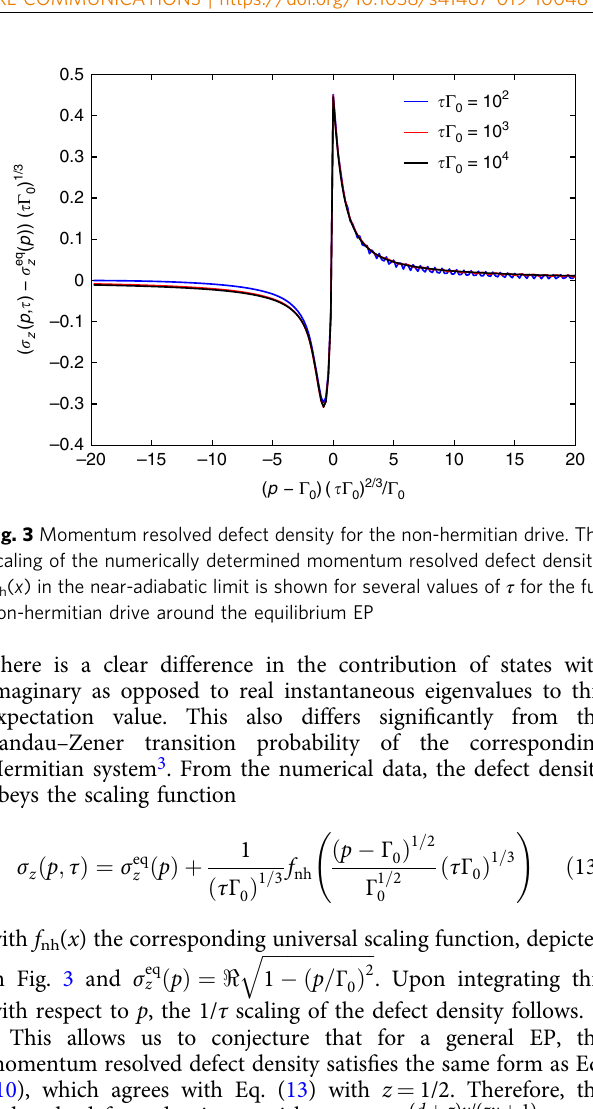
ffiffiffiffiffiffiffiffiffiffiffi p p (cid:3) Γ ffiffiffiffiffiffiffiffiffiffiffi p Γ (cid:3) p